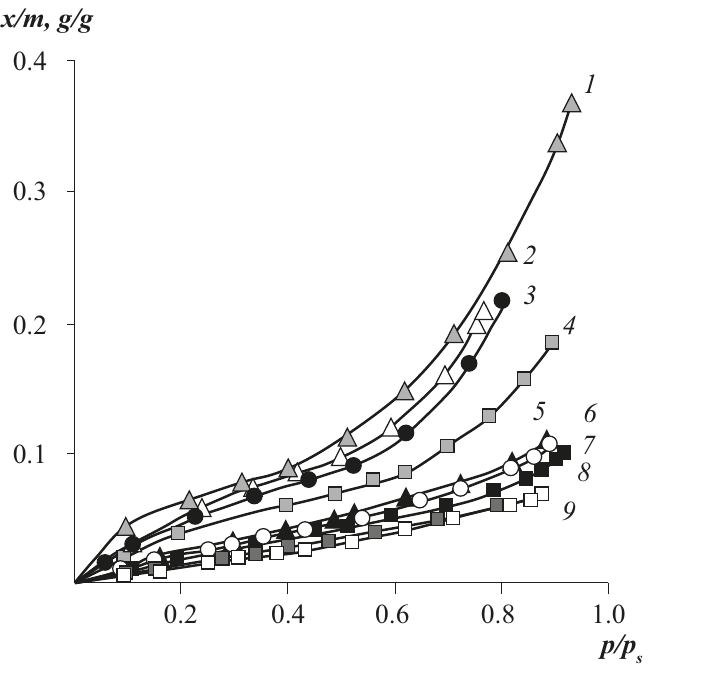
Figure 2. Isotherms of water vapour sorption by cellulose esters of different substitution degrees: 1—0, 2—0.6,3—1.21, 4—1.7, 5—2.00, 6—2.4, 7—2.7, 8—2.8, 9—3.00 at 30 ◦ C.